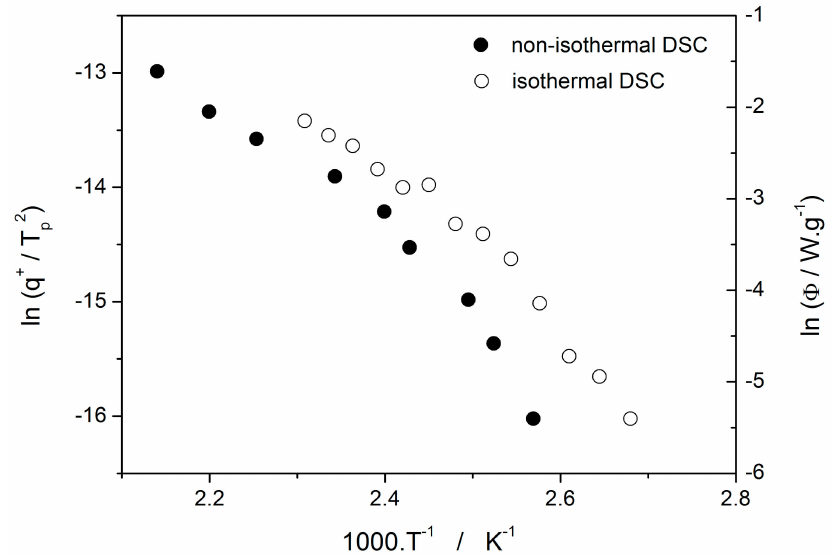
Figure 7. Determination of the crystallization activation energy for selenium glass by the Kissinger method (non-isothermal data) and the Friedman method (isothermal